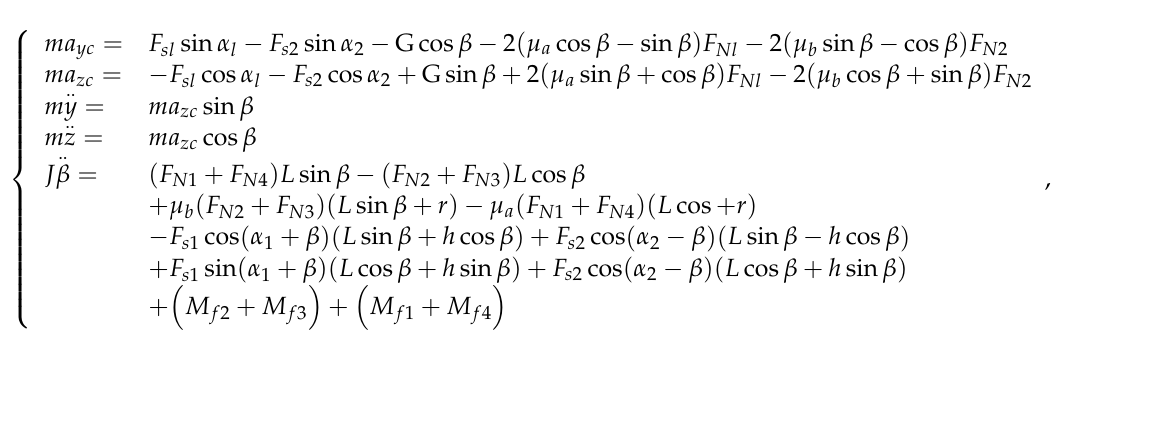
If the robot does not slip sideways and flip sideways, then μ a = μ 1 = μ 4 and μ b = μ 2 = μ 3 . The dynamic equation of DP-Climb in the robot coordinate system { xyzc } can be ob- tained: